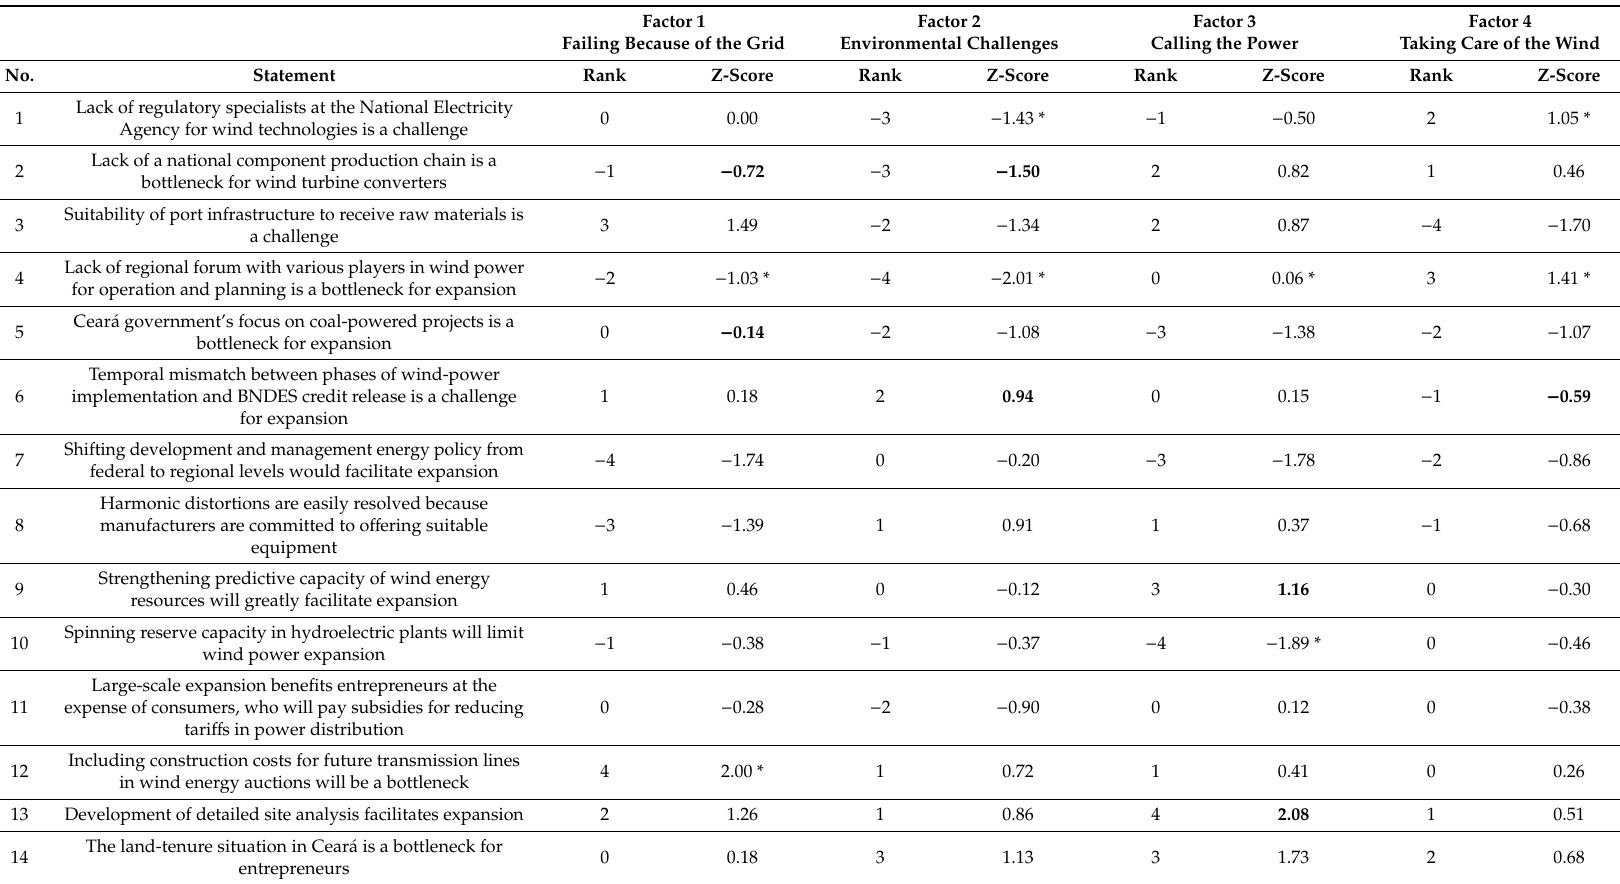
Table A1. Z-scores and rank of each statement by factor. Bold indicates significance at p < 0.05; * identifies significance at p < 0.01. Non-significant “consensus” statements are indicated by